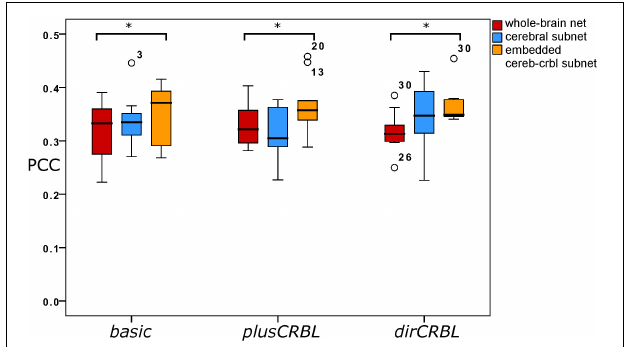
FIGURE 5 | Boxplots of Pearson correlation coefficients for whole-brain network , cerebral subnetwork , and embedded cerebro-cerebellar subnetwork models within each SC construct. Brackets and asterisks indicate significant differences with p <